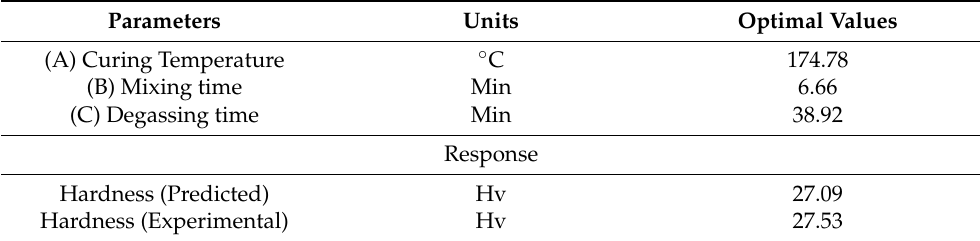
Table 8. Optimal parameters for hardness strength.